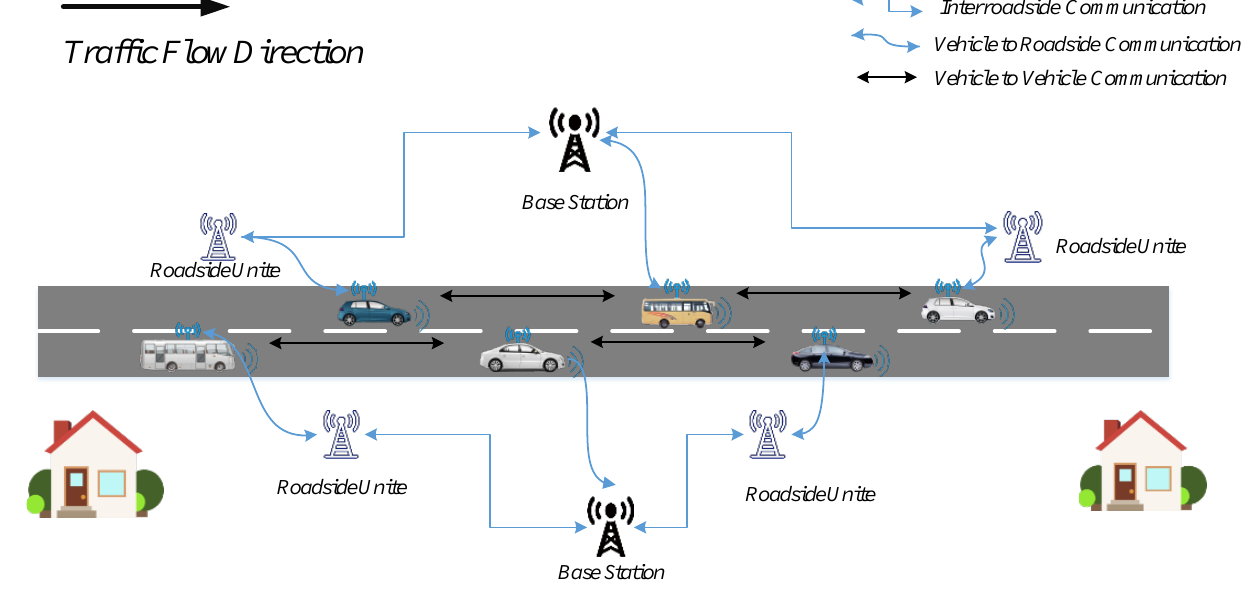
Figure 1. Illustration of Vehicular Ad hoc NETwork (VANET) for autonomous vehicles.